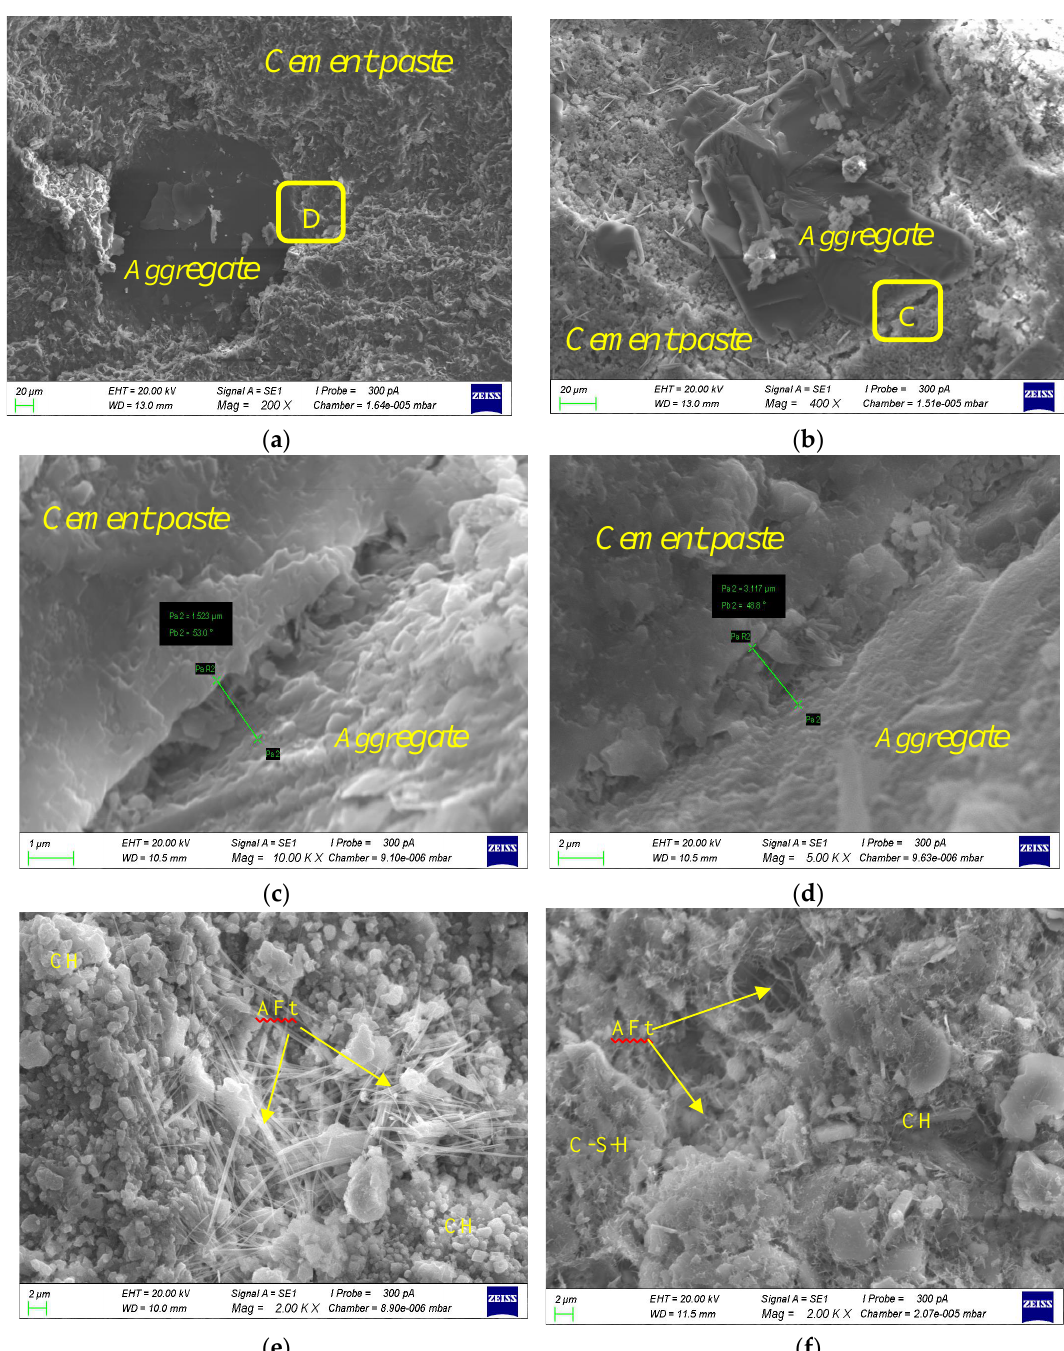
Figure 5. Sample microscopic analysis: ( a ) bonding of aggregate and cement in LMR-CSPB; ( b ) bonding of aggregate and cement in L-CSPB; ( c ) the ITZ of LMR-CSPB; ( d ) the ITZ of L-CSPB; ( e ) the hydration products in the LMR-CSPB; ( f ) the hydration products in the